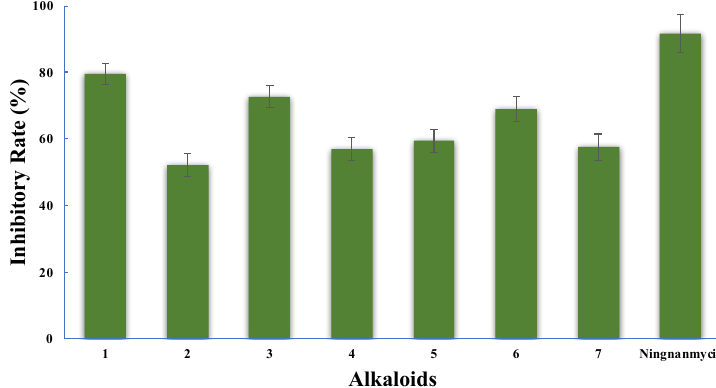
Figure 4. Inhibitory activity of the isolated alkaloids 1 – 7 against the replication of TMV.